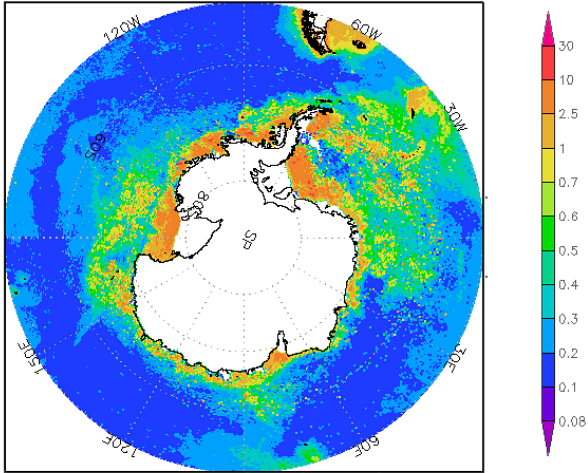
Fig. 7. Map of the chlorophyll a concentration climatology for the Antarctic region. This visualization has been obtained from the Giovanni online data system (Acker and Leptoukh, 2007) developed and maintained by the NASA GES DISC. Observations are based on data from the SeaWiFS and MODIS instruments. | 38